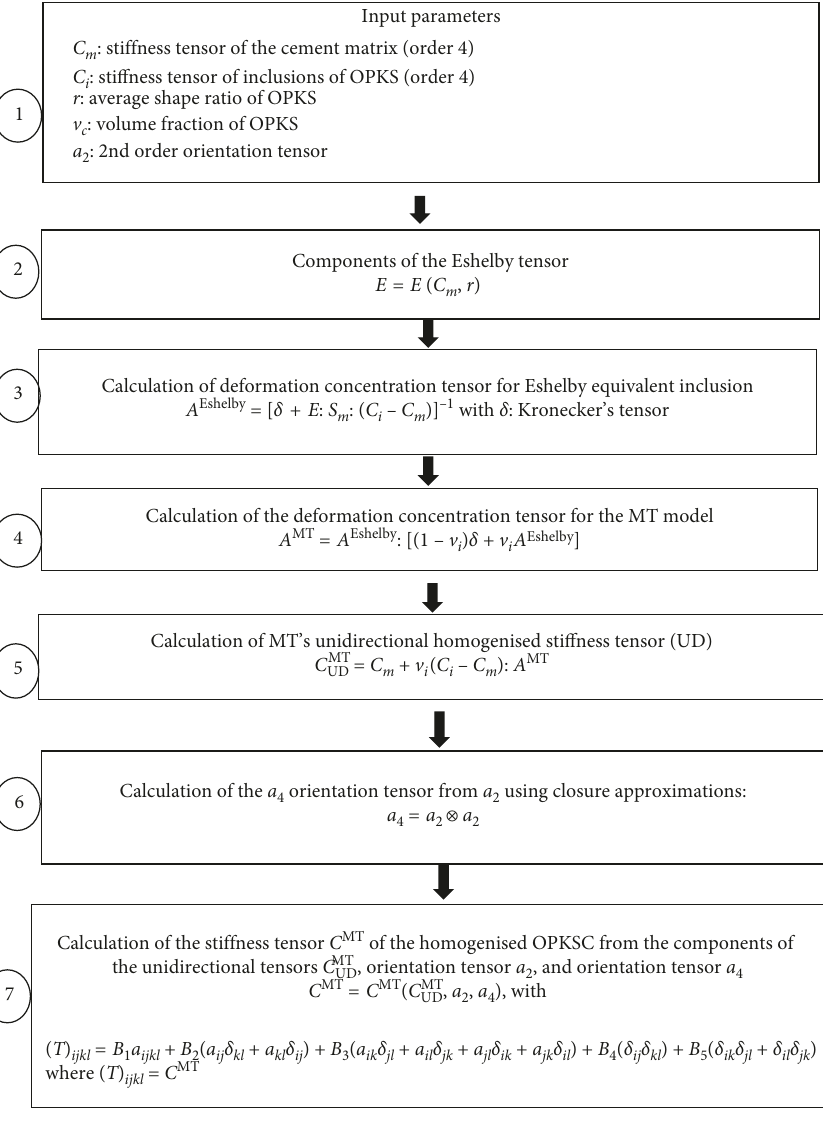
Figure 9: Determination of homogenised stiffness tensor (MT’s